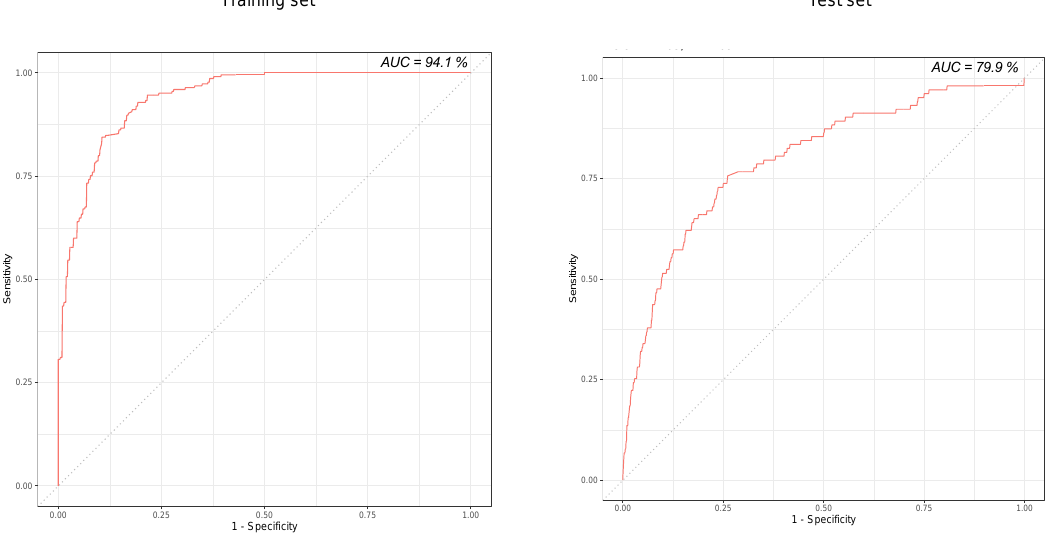
Figure 3. Receiver operating characteristic curve of the prediction model on training set ( left ) and test set ( right ).